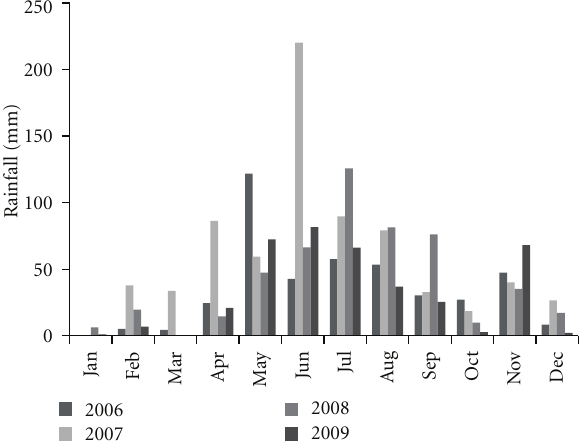
Figure 1: Average monthly rainfall during the test